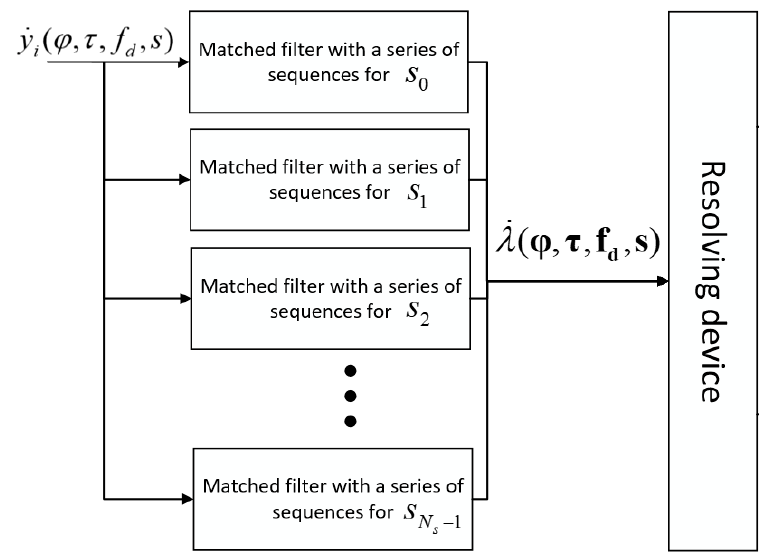
Figure 3. Scheme of the device for joint detection and signal parameter estimation.